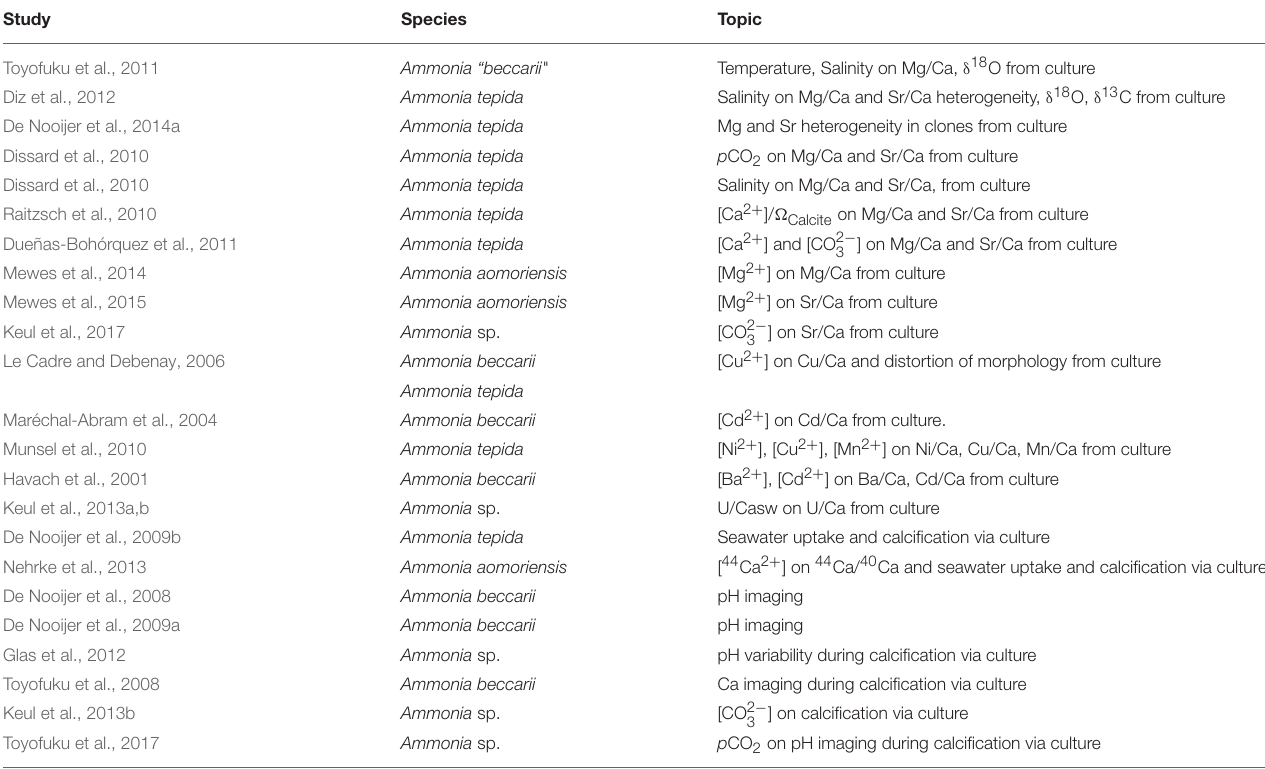
TABLE 1 | Evaluation of geochemical signatures and calcification process in Ammonia